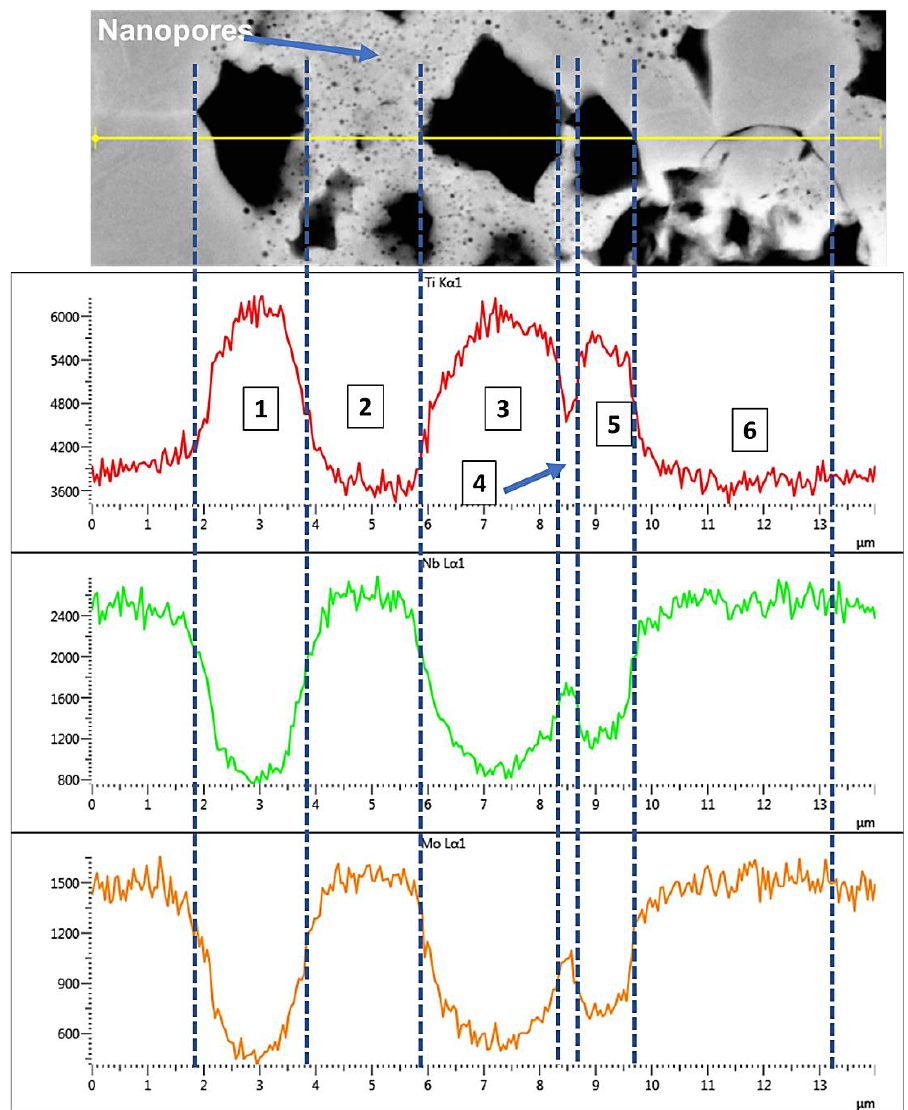
Figure 9. The SEM micrographs and EDS line scan results of the sintered Ti-35Nb-6Mo alloy for 60 h. Dashed blue lines indicate the regions in the microstructure related to the homogeneity of Ti, Nb and Mo elements. The numbers of 1 to 6 indicate the regions in the micrography related to the homogeneity of the microstructure.